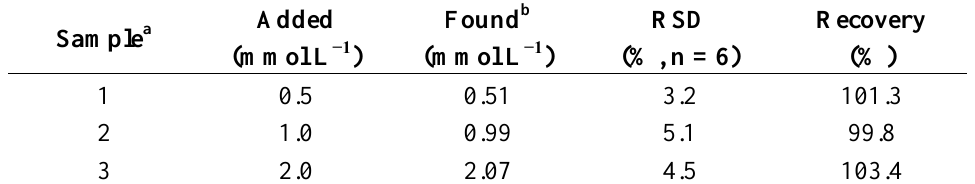
O in disinfected fetal bovine serum (FBS) samples. 2 2